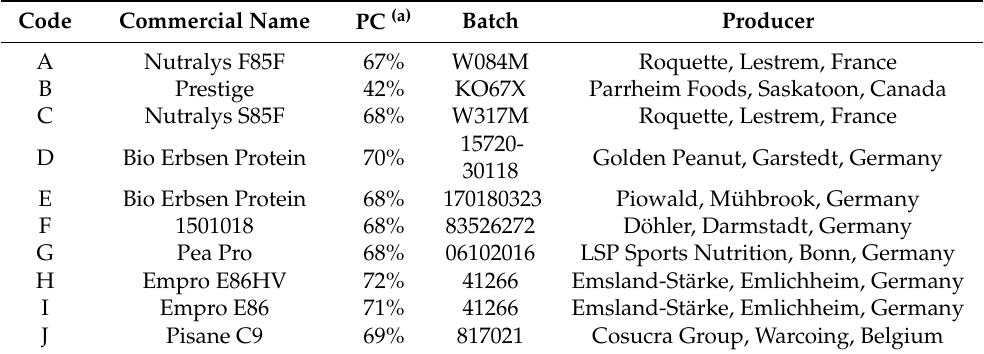
Table 1. List of analyzed pea proteins within FEI project AiF 20197 N.